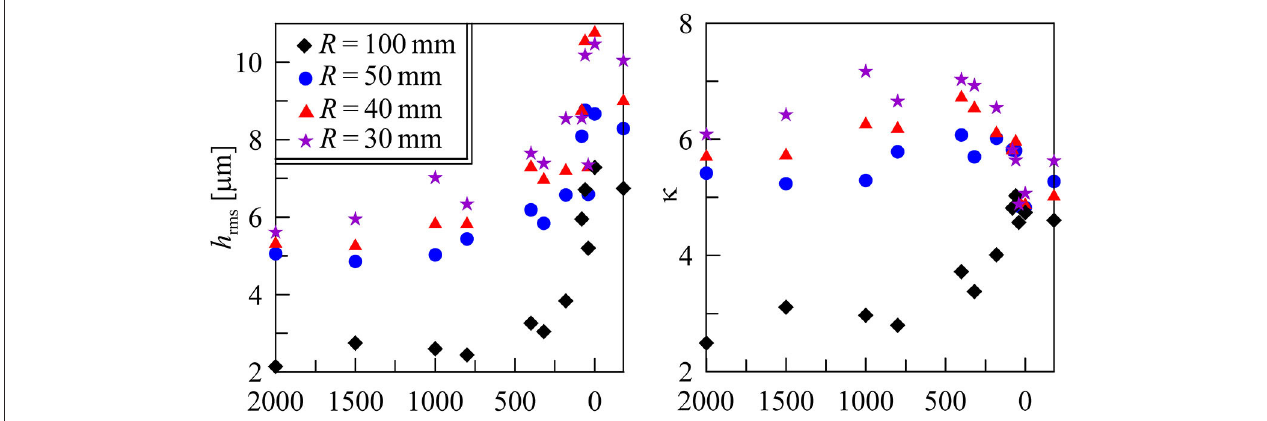
FIGURE 9 | Measured values of h rms and κ for all the cases that we considered, obtained by using C ( q ). We showed the last value “P0 + 180” as a negative value “ − 180” because “P0 + 180” is not a number.